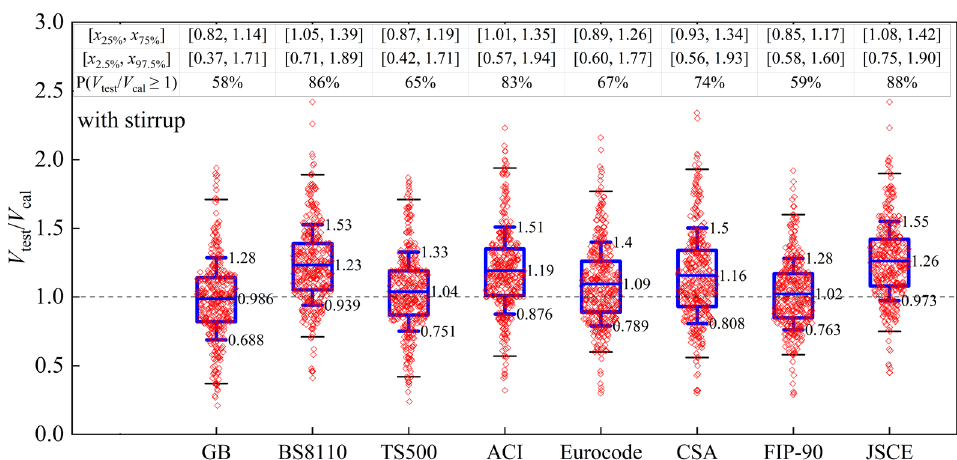
Figure 2. Codes: overall prediction results for beams with stirrups.